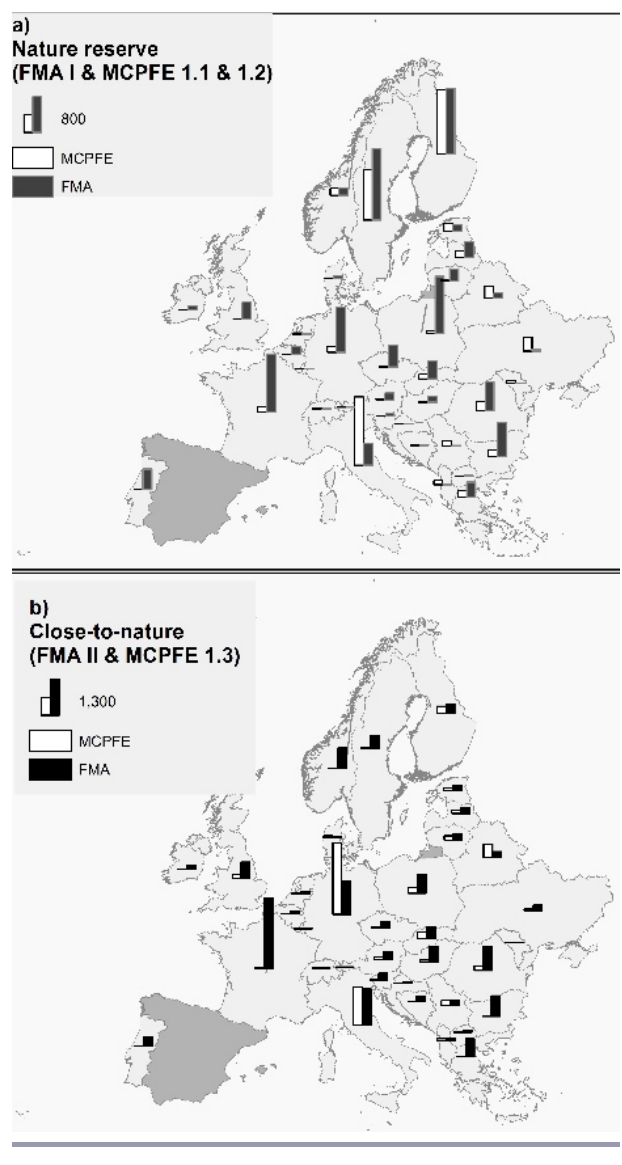
Fig. 3 . Comparing forest management approach (FMA) I and II with Ministerial Conference on the Protection of Forests in Europe (MCPFE) class 1. (a) For each country, the summed area reported under MCPFE 1.1 and 1.2 is shown (white bar) next to the area predicted most suitable for FMA I (black bar). (b) For each country, the area reported under MCPFE 1.3 is shown (white bar) next to the area predicted most suitable for FMA II (black bar). For Spain, no forest area according to the MCPFE classification is reported (MCPFE 2007). Numbers in the legend show the area (km 2 ) represented by the